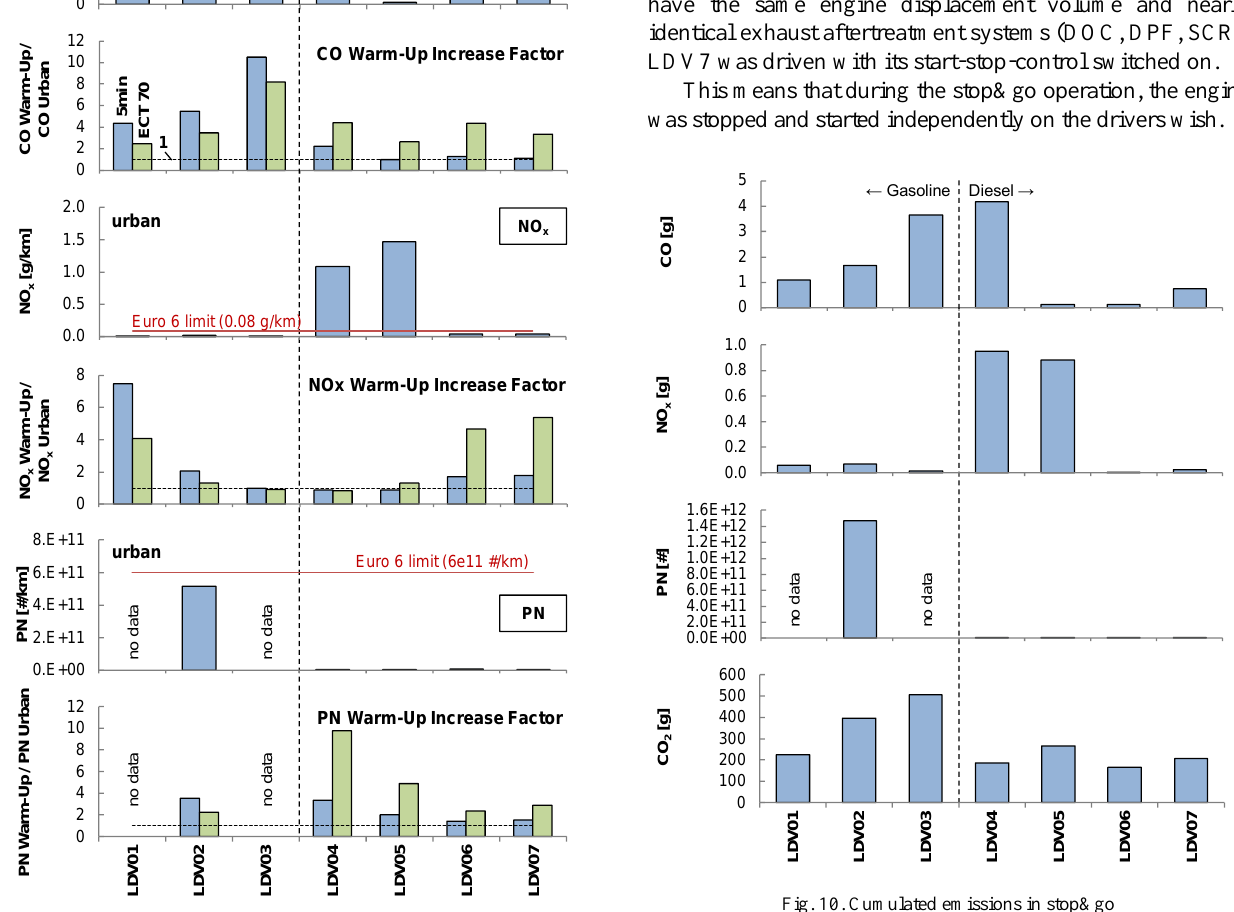
Fig. 9. Specific emissions and their increase factors in the warm-up phase